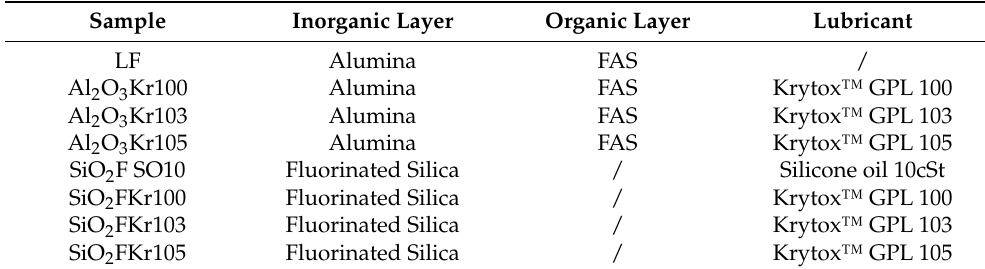
Table 1. Summary of the tested coating